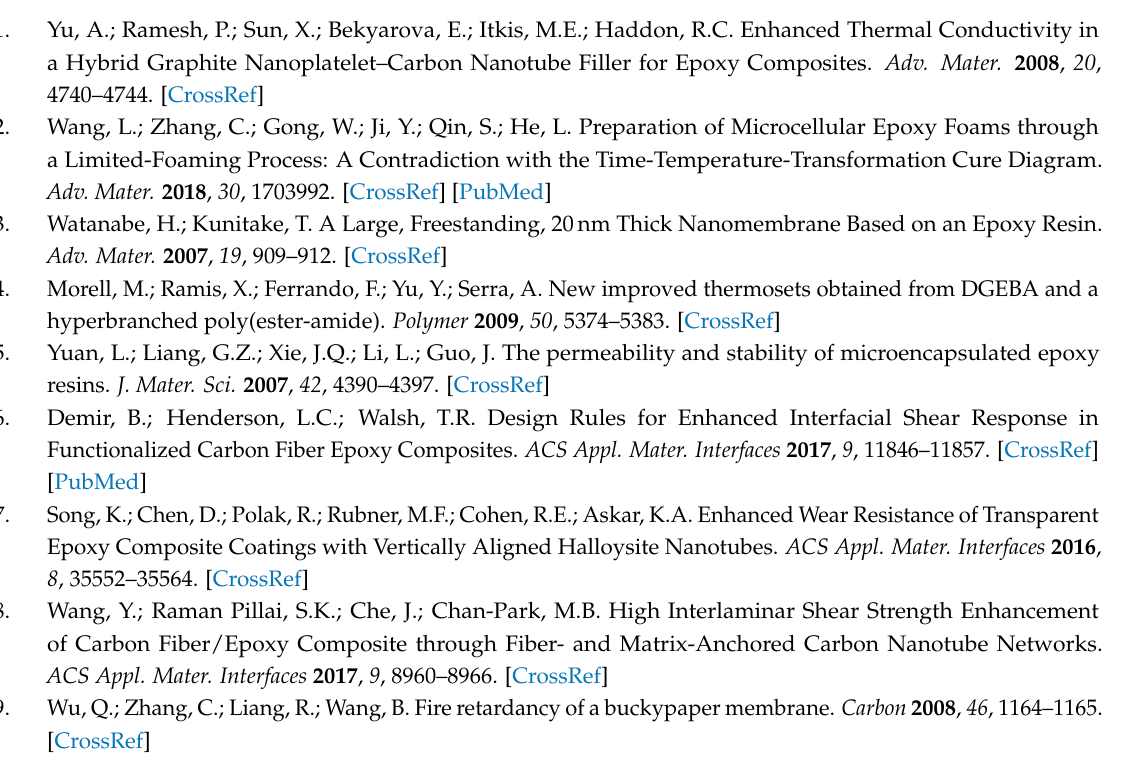
s1: Figure S1: Derivative thermogravimetric analysis (DTG) for MRP and ET3228 tackifiers with microencapsulated red phosphorus (MRP) contents in the range of 0–48 wt.%, Figure S2: Temperature dependence of complex viscosities for the EP3228 resin mixing with MRP content in the range of 0–7.5 wt.%, Figure S3: Scanning electron microscopy (SEM) images of the external surfaces of resin transfer molded (RTM) epoxy composites preformed by the ET3228 tackifiers containing ( a ) 0, ( b ) 23, ( c ) 38, and ( d ) 48 wt.% MRP, and fracture surfaces of RTM epoxy composites preformed by the ET3228 tackifiers containing ( e ) 0, ( f ) 23, ( g ) 38, and ( h ) 48 wt.% MRP before flaming, Table S1: MRP and ET3228 contents in composites, Table S2: MRP and ET3228 contents in preforms, Table S3: First burning time (t 1 ), secondary burning time (t 2 ), and dripping observed for RTM composite samples preformed by the ET3228 tackifiers containing 0, 23, 38, and 48 wt.% MRP, and cured resin samples containing 0, 2.5, 5, and 7.5 wt.% MRP, Table S4: Combustion calorimetric test (CCT) results for the composites. Video S1: Flammability